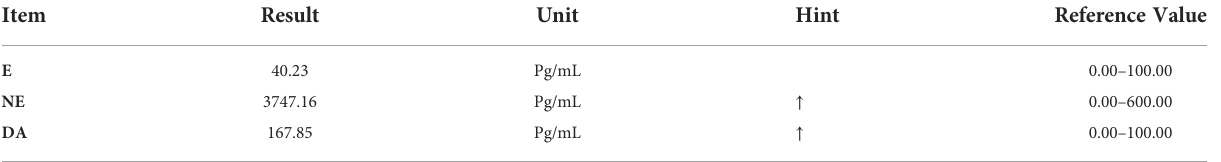
TABLE 2 Plasma catecholamine concentrations (primary